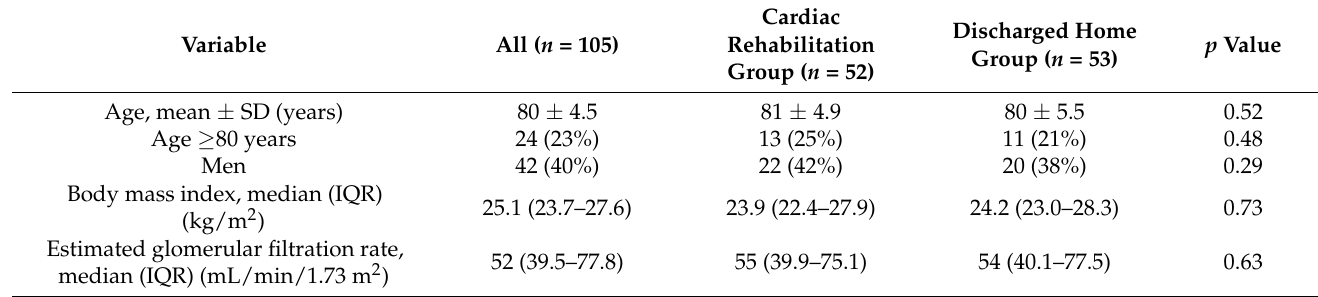
Table 1. Baseline clinical and echocardiographic